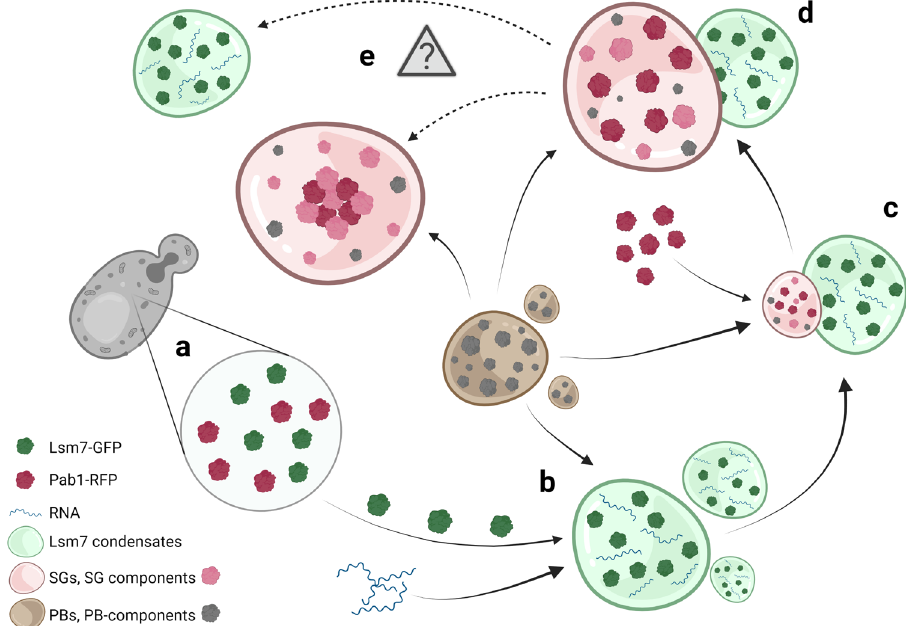
Fig. 8 A schematic diagram showing an active function of Lsm7 phase separation in regulating SG formation under 2-DG treatment. a Prior to stress treatment, Lsm7-GFP and Pab1-RFP are diffusely distributed in the cytosol. b Upon 2-DG treatment, Lsm7 quickly phase separates, creating condensates in conjunction with available RNA and supported by PB components. c Pab1 is recruited and starts to demix, aided by PBs and/or speci fi c PB components. The subsequent SGs associate on the side of the Lsm7 condensates. d Over time SGs increase in size whereas the Lsm7 condensates remain similar in size. e Lsm7 condensates might not be needed for maintenance of already formed SGs, and SG core maturation. Hence, it might be that Lsm7 condensates and SGs dissociate (indicated by dotted arrows). Created with